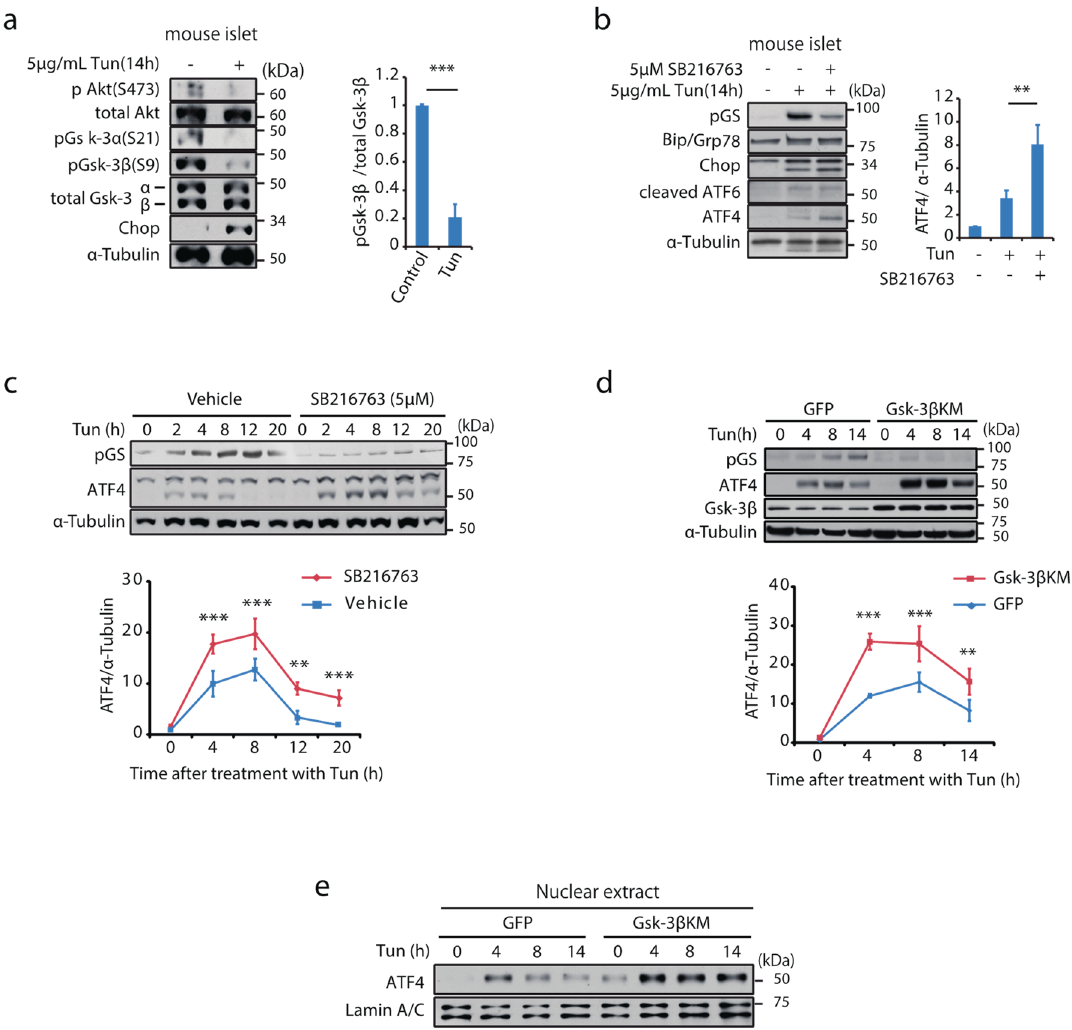
Figure 1. Gsk-3 negatively regulates ATF4 protein expression in mouse β cells under ER stress. ( a ) Isolated mouse islets were incubated with tunicamycin (5 μ g/mL) for 14 h and Akt-Gsk-3 signalling was analysed by Western blot. Relative pGsk-3 β /Gsk-3 β are shown in the graph as mean ± SD (n = 3). *** p < 0.001 by unpaired student’s t -test. ( b ) Isolated islets were incubated with tunicamycin for 14 h in the presence or absence of GSK-3 inhibitor, SB216763 (5 μ M) and protein lysates were analysed by Western blotting using indicated antibodies. Relative expressions of ATF4 are shown as mean ± SD (n = 3). ** p < 0.01 by one-way ANOVA followed by Bonferroni’s post hoc test. MIN6 in which Gsk-3 activity was inhibited by ( c ) SB216763 (5 μ M) or ( d ) by retrovirus-mediated induction of HA-Gsk-3 β KM were incubated with tunicamycin (5 μ g/mL) for indicated periods. Protein lysates were analysed by Western blotting. Relative expression of ATF4 to the basal are expressed as mean ± SD (n = 3, respectively). ** p < 0.01, *** p < 0.001 by two-way ANOVA with Bonferroni’s post hoc test. ( e ) The nuclear extracts of MIN6 stably expressing GFP or HA-Gsk-3 β KM were prepared after incubation with tunicamycin at indicated time points and were analysed by Western blotting using indicated antibodies. Representative images of two independent experiments are shown.